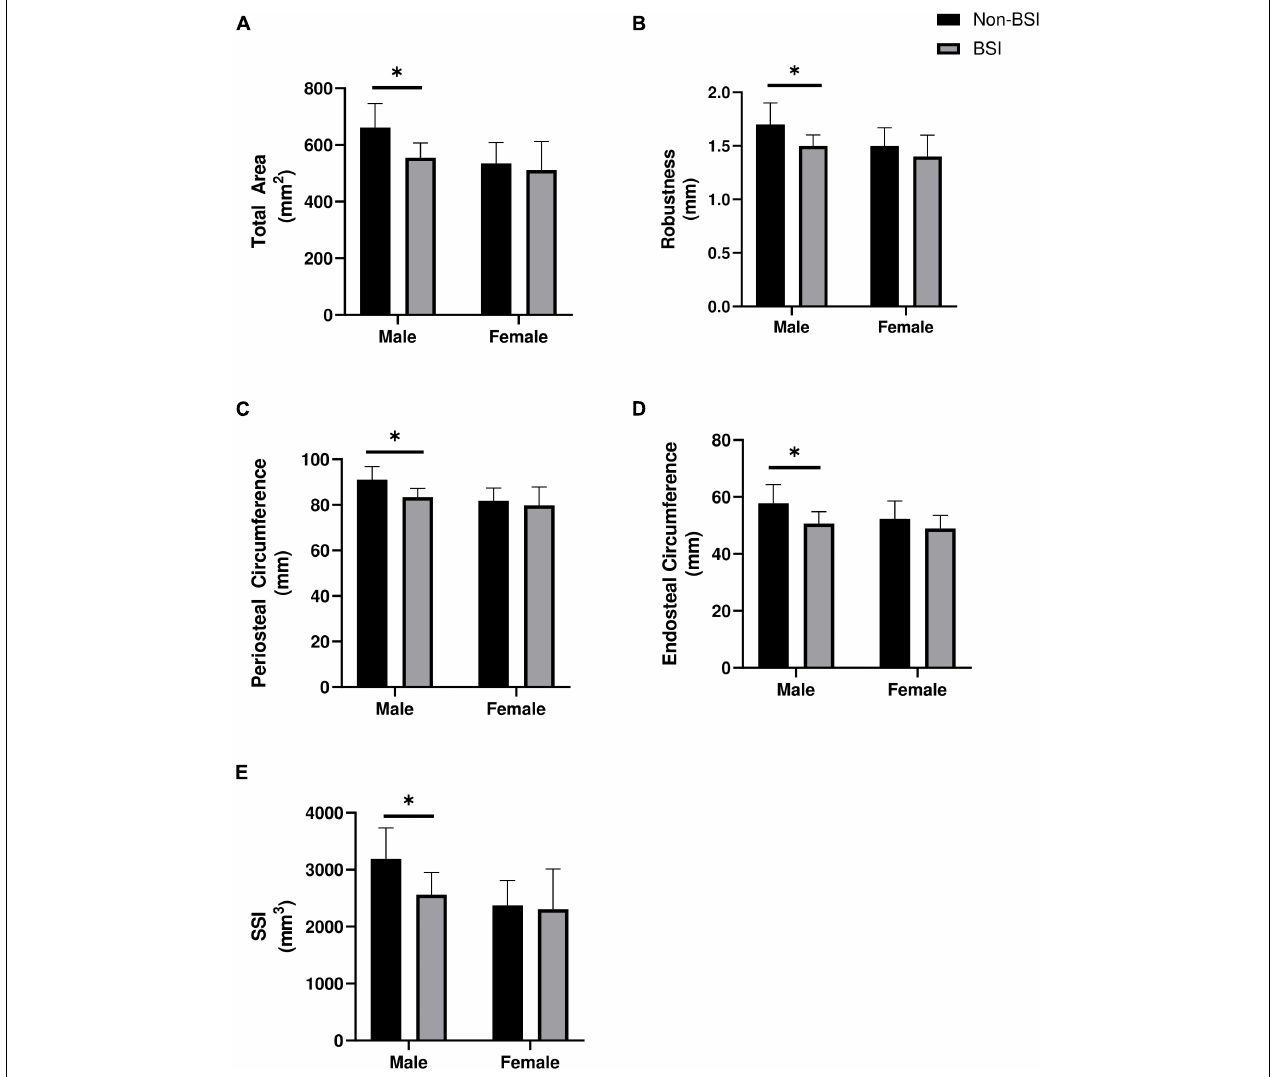
FIGURE 1 | Baseline differences in (A) Total area, (B) Robustness, (C) Periosteal circumference, (D) Endosteal circumference, and (E) Estimated strength of the proximal diaphysis (66% site) between those who were diagnosed with a bone stress injury (BSI) and those who did not in male ( n = 6; n = 376) and female ( n = 4; n = 118) officer candidates. ∗ Indicates p < 0.05. Data are mean ± standard deviation. Mann-Whitney U -tests were used to compare estimated strength (SSI) and total area in women and SSI in men, all other comparisons utilized